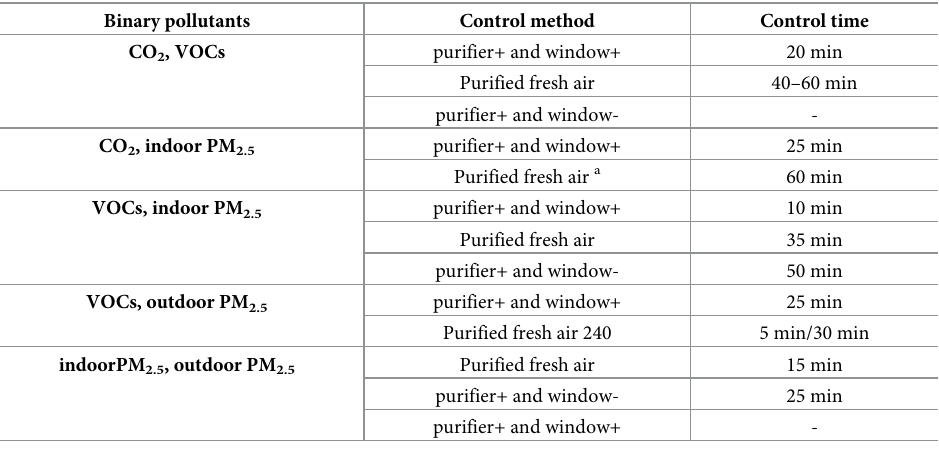
Table 3. Comparison of control time required for binary